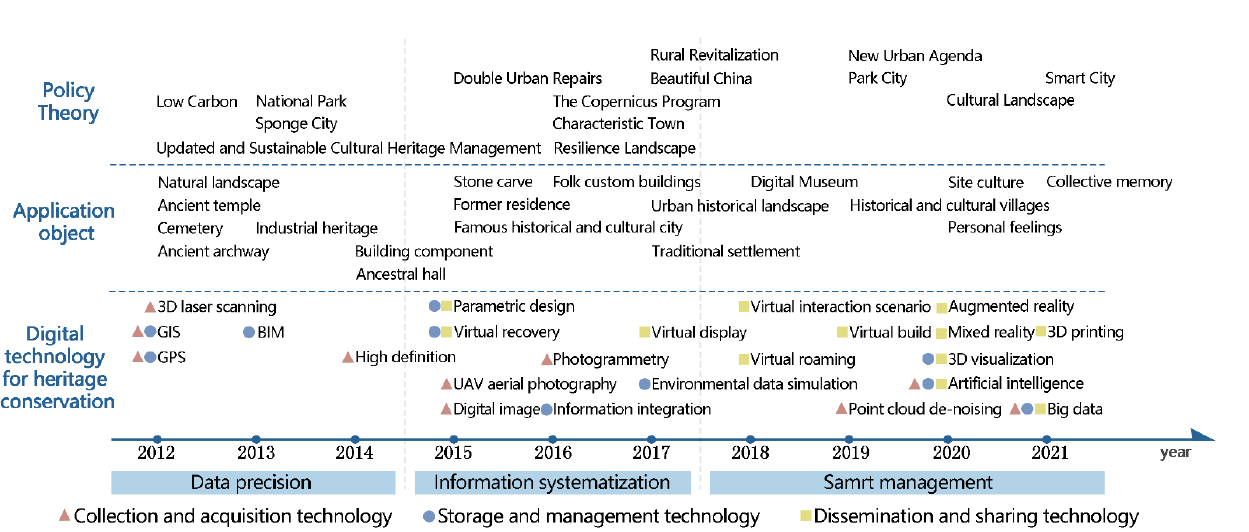
Figure 5. Landscape architecture heritage protection digital technology keywords cluster sequence diagram.